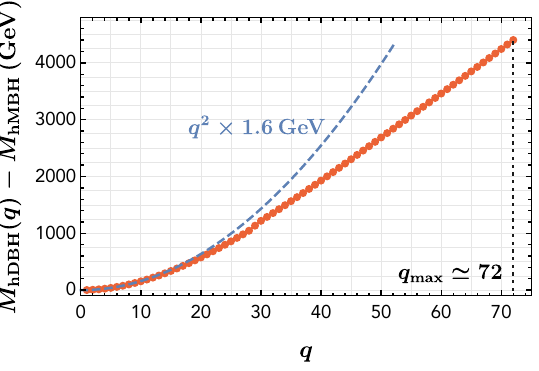
Figure 3 . The mass difference between extremal hairy dyonic and magnetic black holes for different electric charge q . The upper charge limit q max ’ 72 or O (2 π/e 2 ) is obtained by requiring an exponentially decreasing behavior for f ( r ) at large r